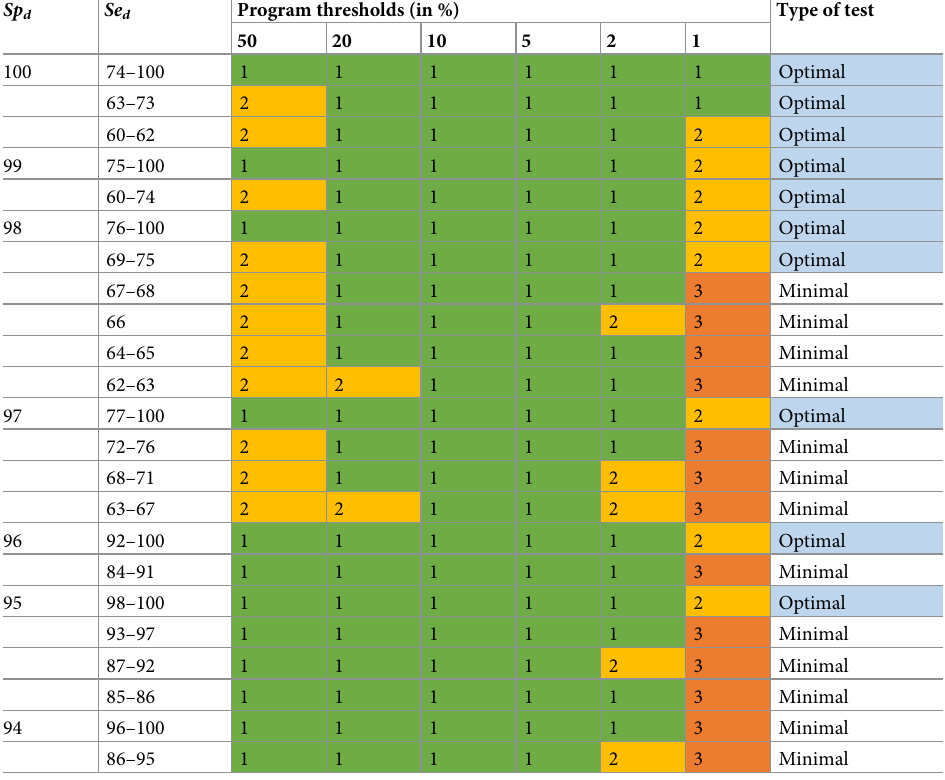
sep- undertreat is overtreat